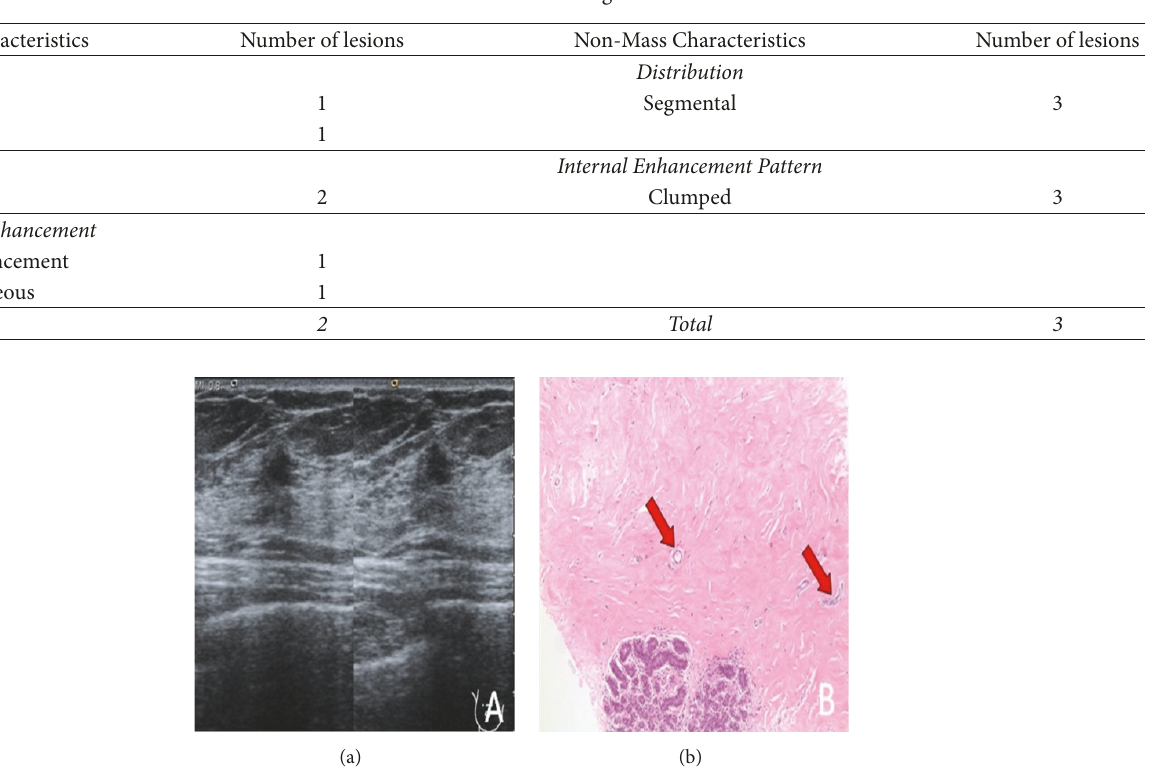
Figure 4: 41-year-old woman presenting for screening. Mammography (not shown) demonstrated heterogeneously dense breast with no suspicious abnormality. (a) Screening ultrasound shows a hypoechoic mass with irregular shape and margin. The patient was lost to follow-